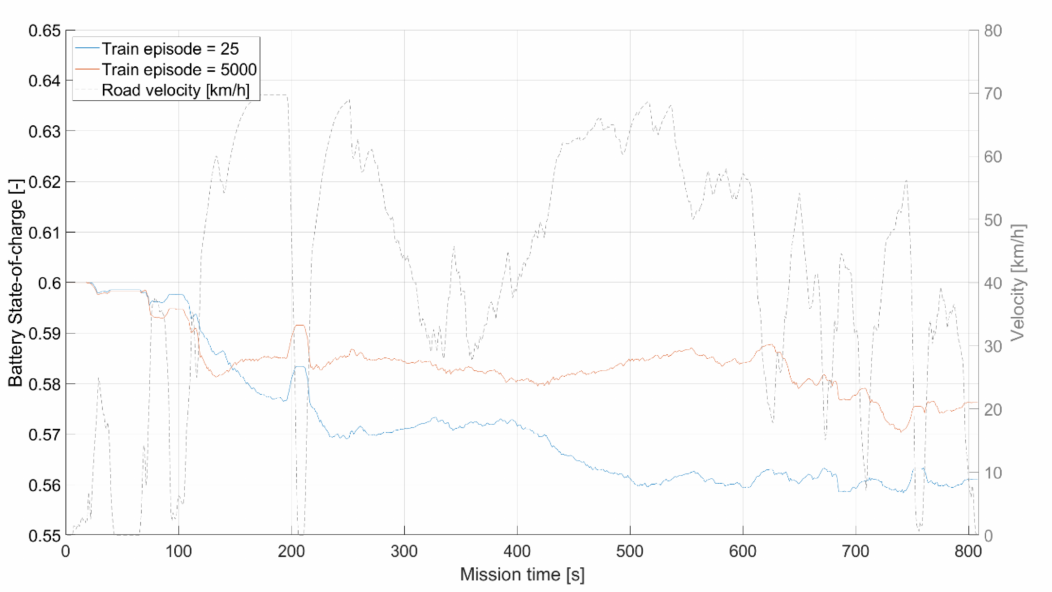
Figure 13. Battery SoC over CLUST1 evaluated throughout the first saved and last training episodes.